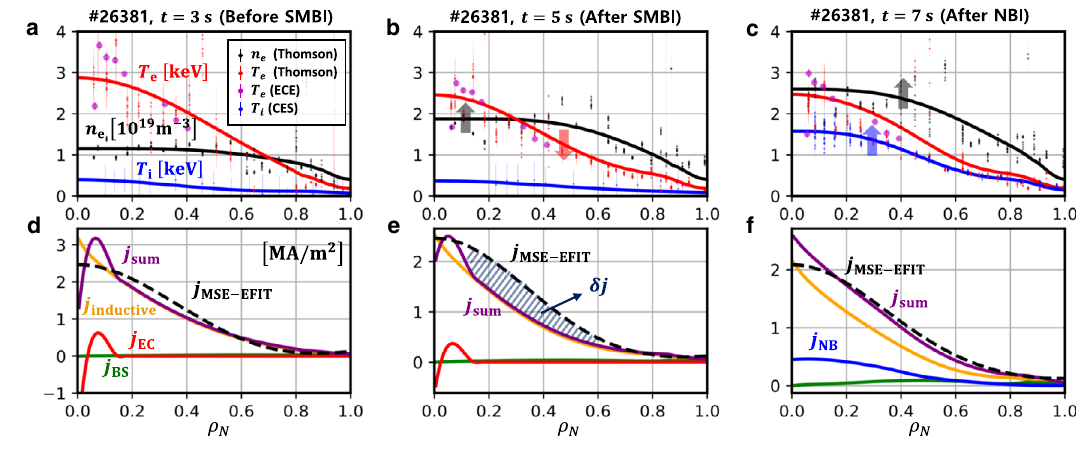
Fig. 4 | Kinetic pro fi les and current density pro fi les in #26381. Electron density ( n e ) and temperature( T e ) and iontemperature( T i ) at t =3s ( a ),5s ( b ),and 7s ( c ). Inductive ( j inductive ), neutral beam injection-driven ( j NB ), electron cyclotron-driven ( j EC ), bootstrap ( j BS ) current density, and summation of each component of